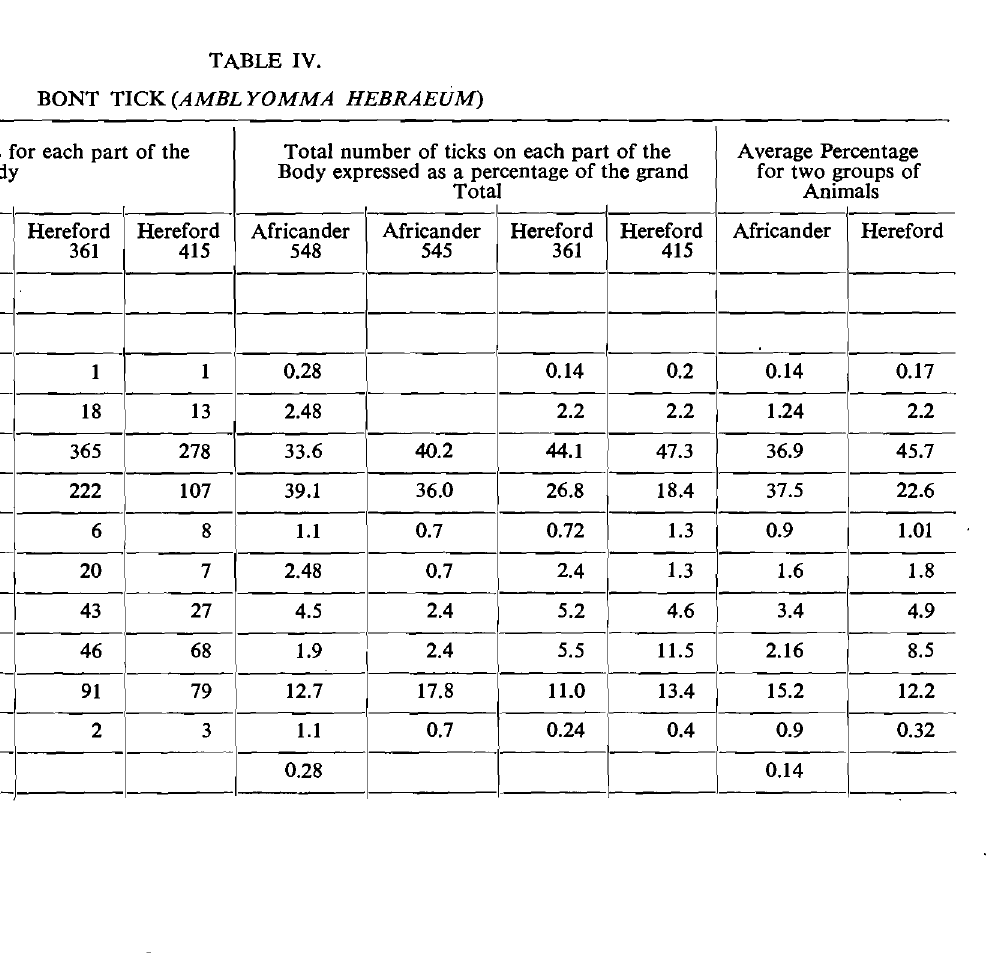
BONT TICK (AMBL YOMMA